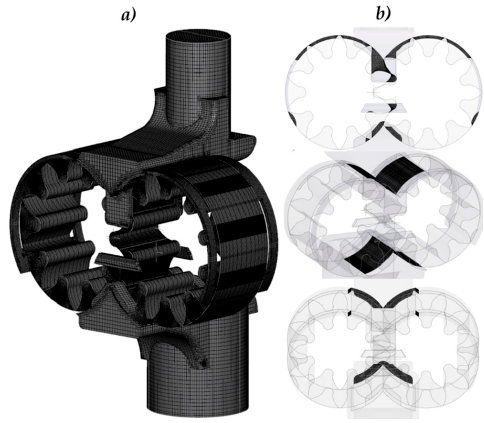
Figure 4. ( a ) Binary tree mesh, ( b ) mismatched grid interface (MGI) between volumes.